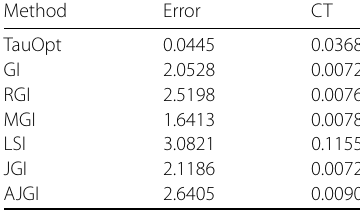
Table 5 Errors and computational time for Example 6.2 Method Error CT